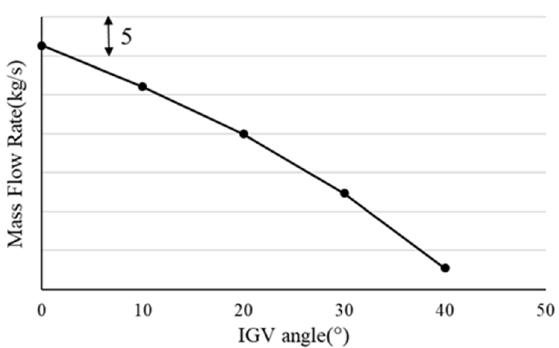
Figure 8. The relationship between IGV turning angle and mass flow. Under a fixed IGV opening degree, VGV1 and VGV2 are separately adjusted, and the